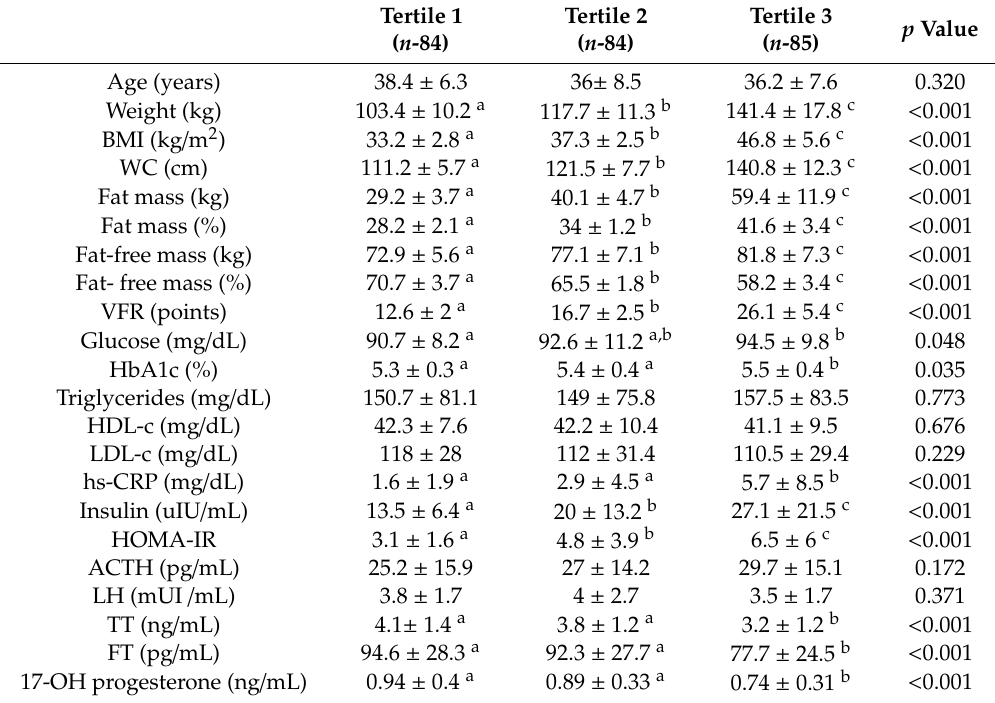
Table 1. Characteristics of the study population according to tertiles of body fat percentage.